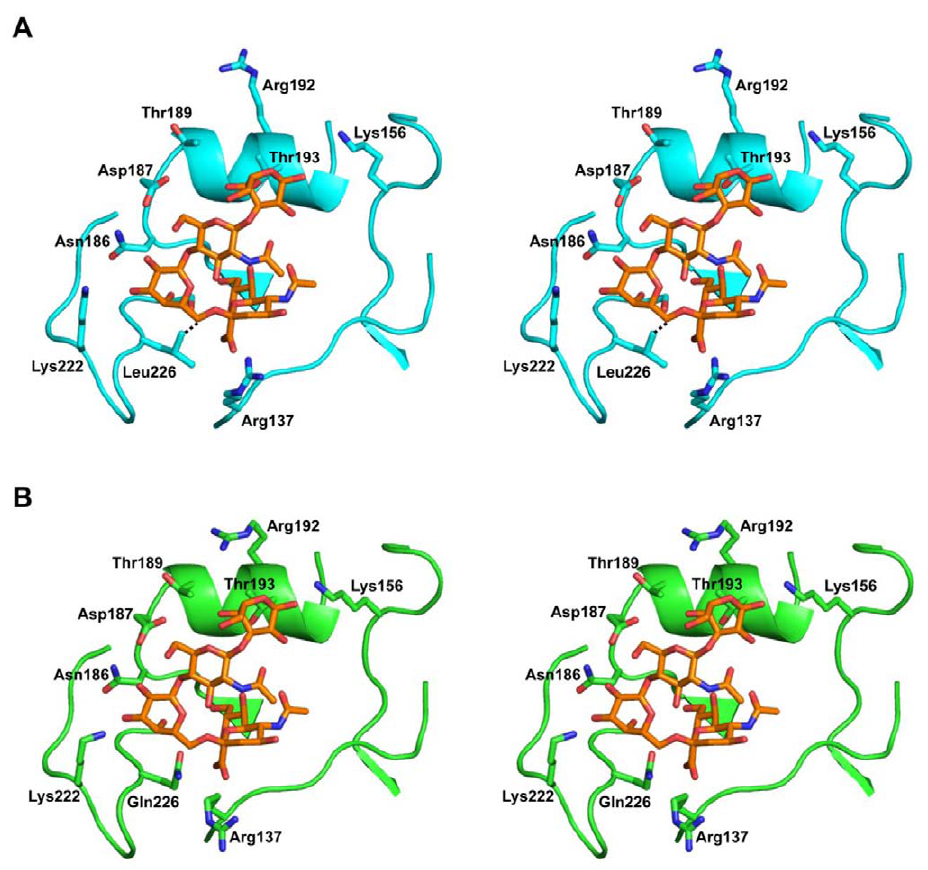
Figure 3. Structural model of human H2N2 viruses with a 2,6 receptor. A , Stereo view of homology based structural model of Alb/58 HA complexed with a 2,6 oligosaccharide. This model was constructed using a representative human H2N2 HA – a 2,6 receptor co-crystal structure (PDB ID: 2WR7) as template. The optimal contact between the critical Leu226 with the C6 atom of SA a 2,6-linked to Gal motif is shown with dashed line. B , Stereo view of homology based structural model of ElSalv/57 HA complexed with a 2,6 oligosaccharide. This model was constructed using an avian- like H2N2 HA (PDB ID: 3KU3) as template. The main differences in contacts between A and B are in positions 226 and 228 that make contacts with SA a 2,6-linked to the penultimate Gal and in 156 position that makes contacts with additional sugars at the reducing end of penultimate Gal. The sugar is shown as a stick representation colored by atom (carbon in orange , oxygen in red and nitrogen in blue ). The homology based structural models were constructed as described previously [18].